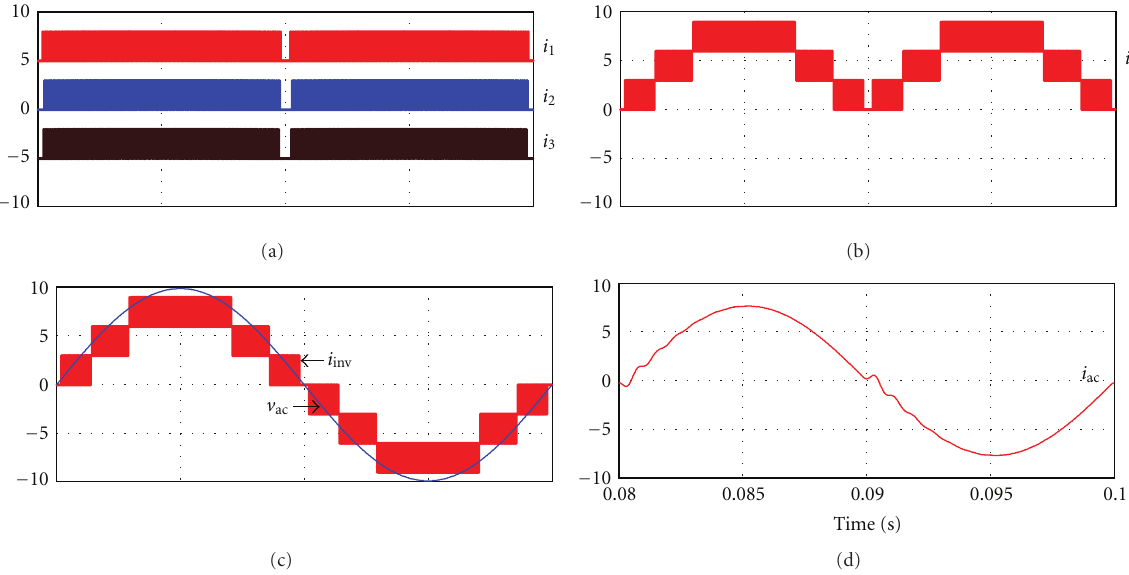
Figure 19: Simulated waveforms of the multimodules hybrid PV/wind system with phase-shifted PWM operating under the conditions of I f m = m = m = I = I = 50Hz and f pv1 wind pv2 , pv1 wind pv2 , line